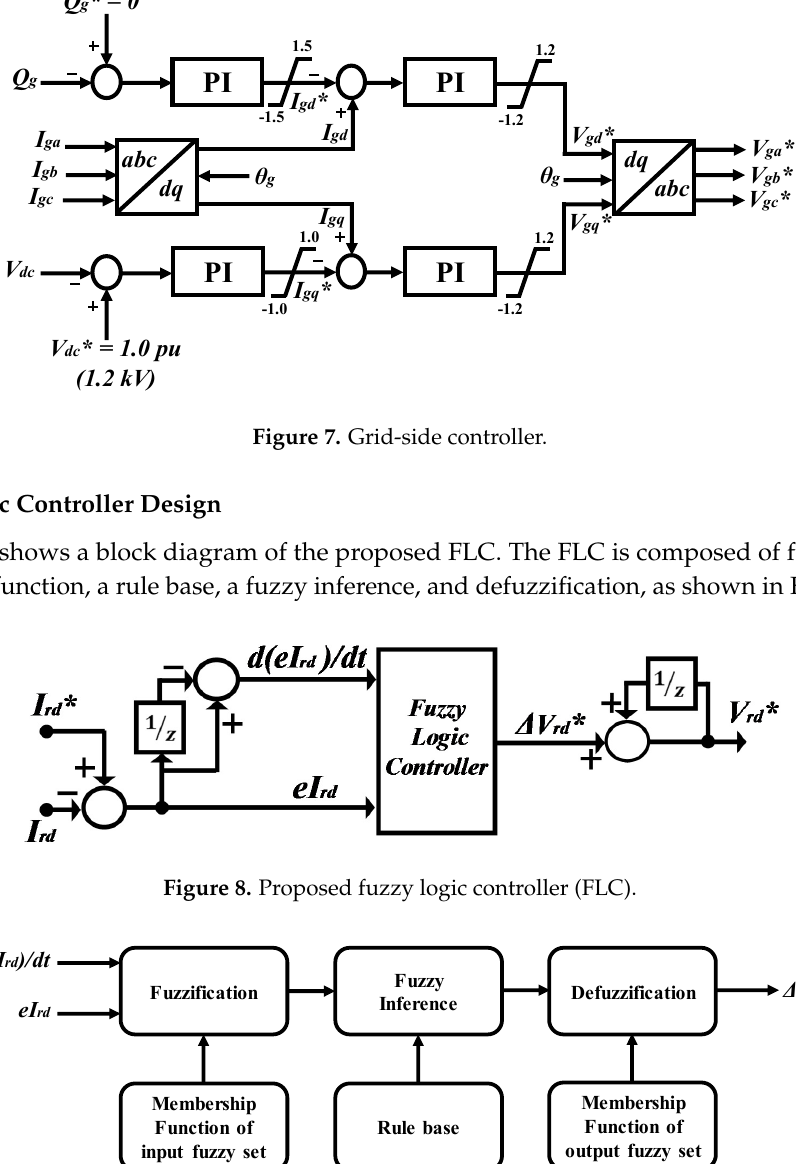
Figure 9. Internal structure of the FLC.